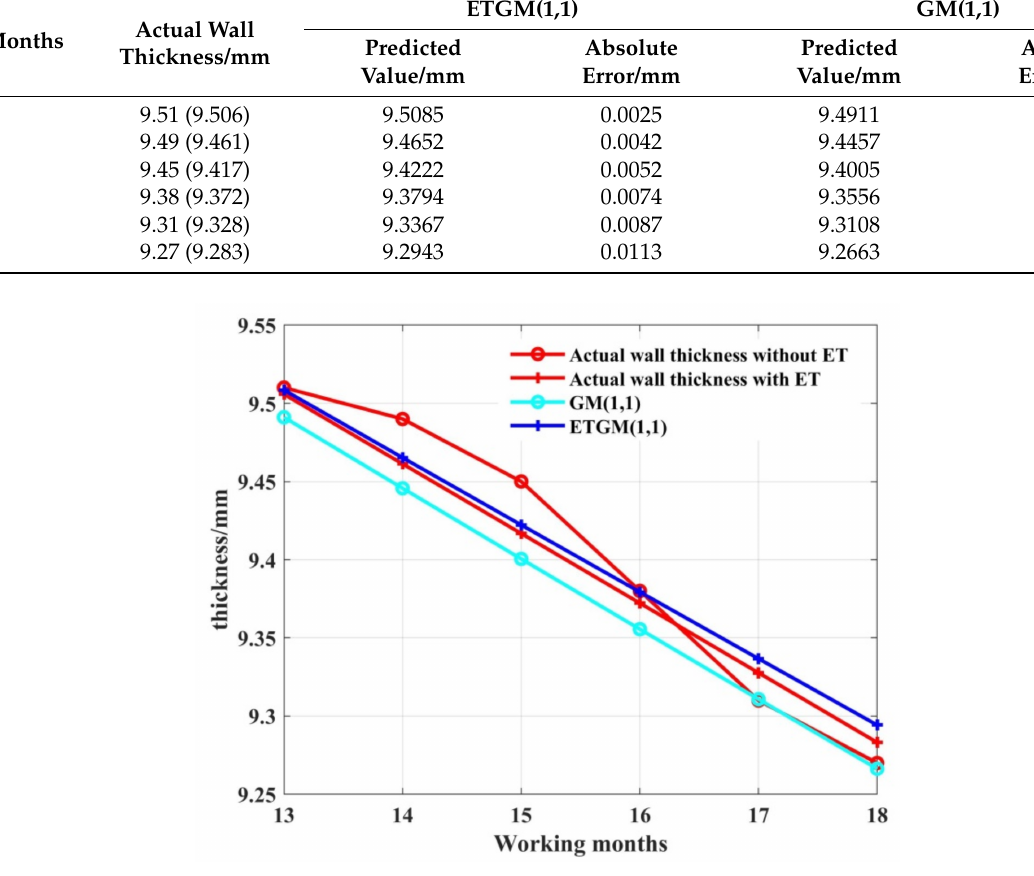
Figure 6. Prediction curve for wall thickness.